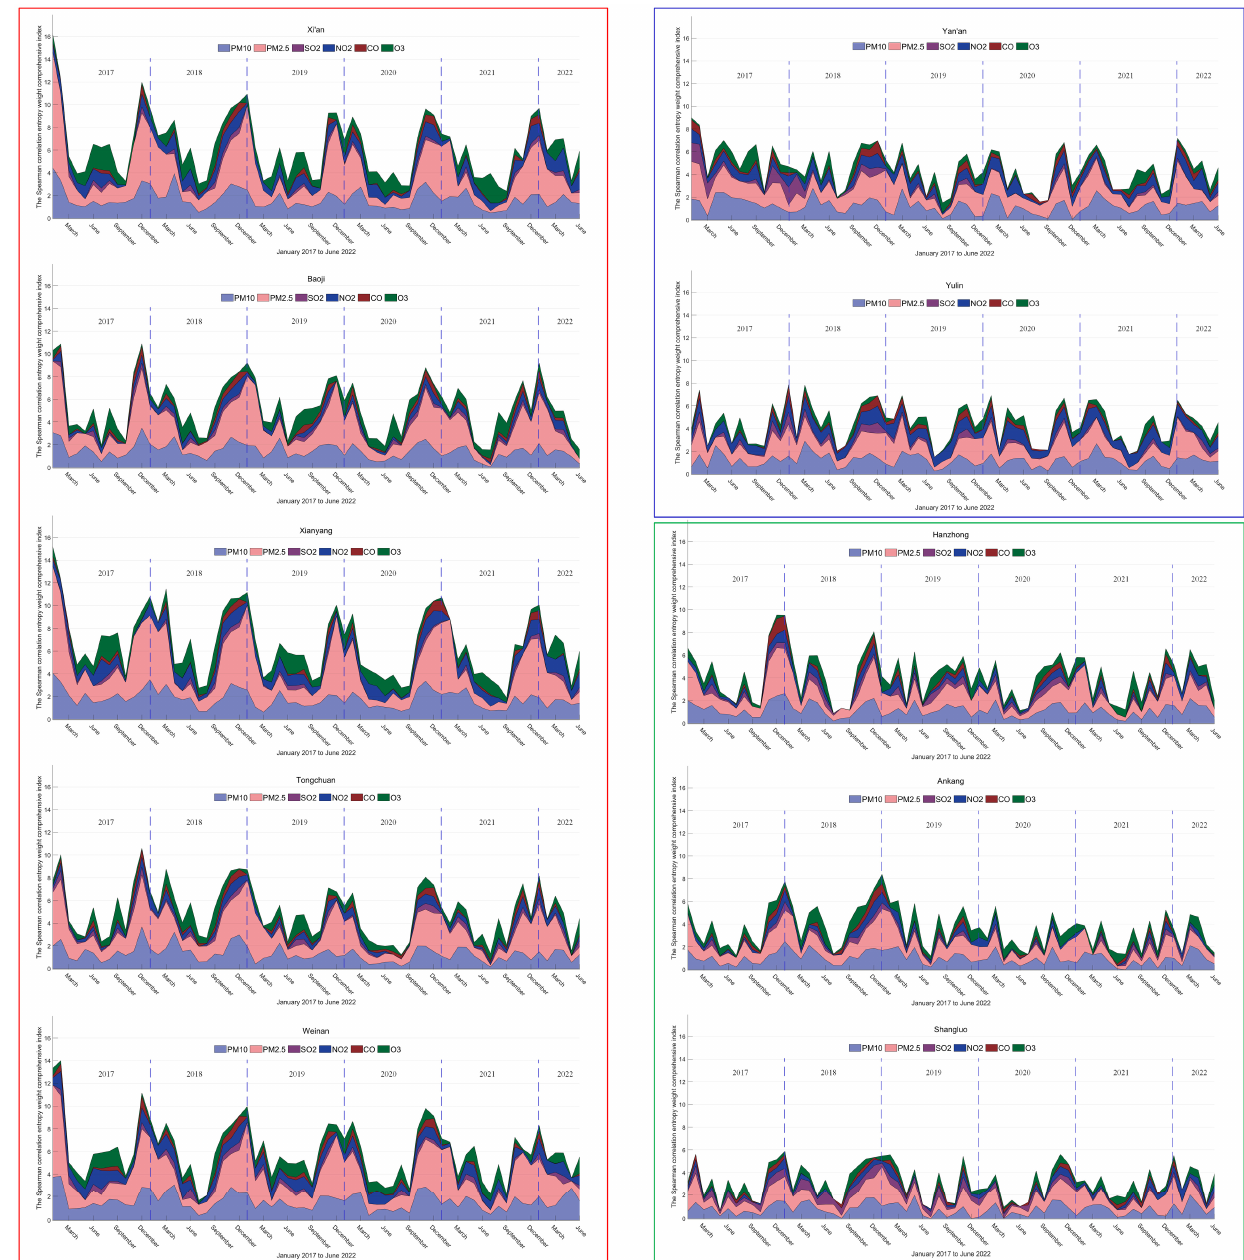
Figure 2. The monthly change trends for the comprehensive Spearman correlation entropy weight index values of 10 cities from 1 January 2017 to 30 June 2022 (the red, blue, and green boxes contain the central, northern, and southern cities of Shaanxi Province, respectively).